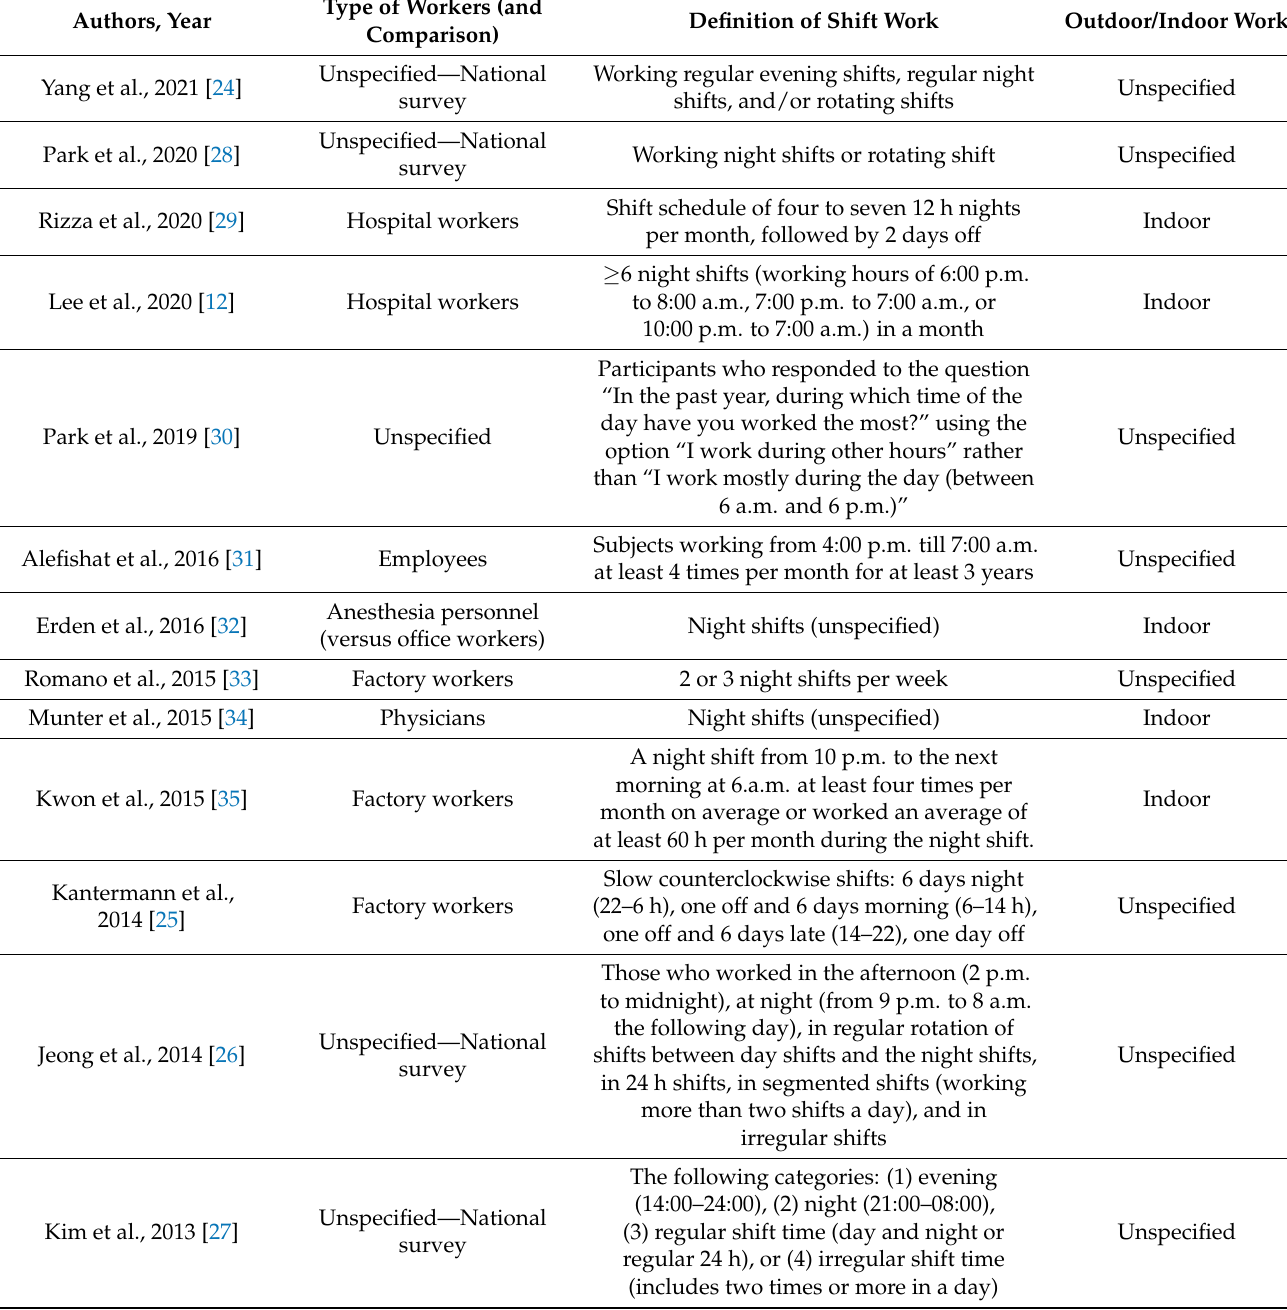
Table 2. Characteristics of workers and shift